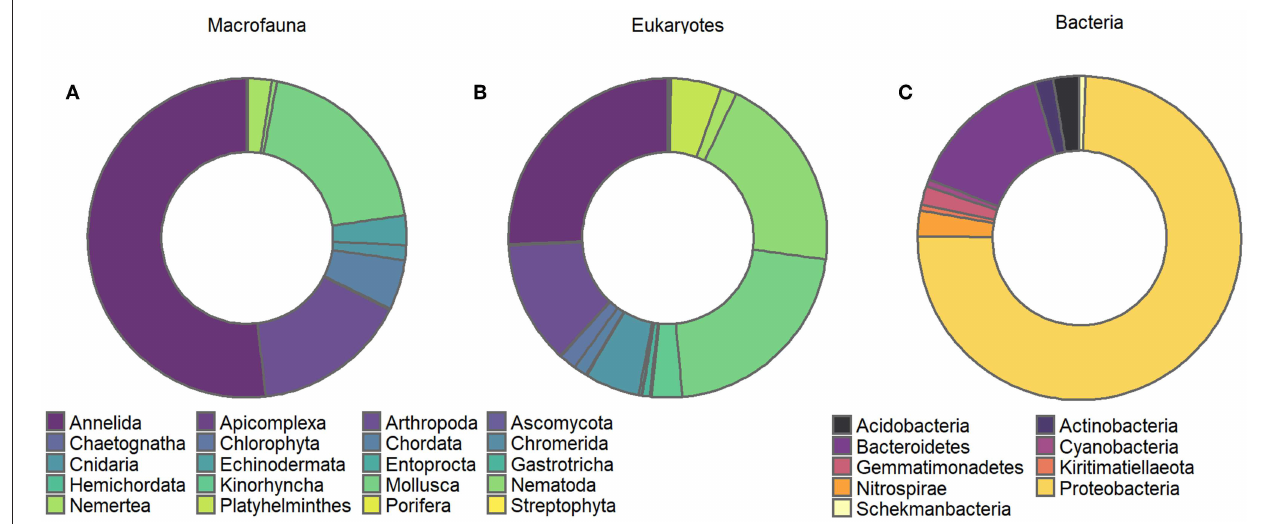
FIGURE 2 | Chart of proportional abundance of different: (A) macrofauna, (B) eukaryote, and (C) bacterial phyla identified from soft sediment assemblages inhabiting experimental plots.